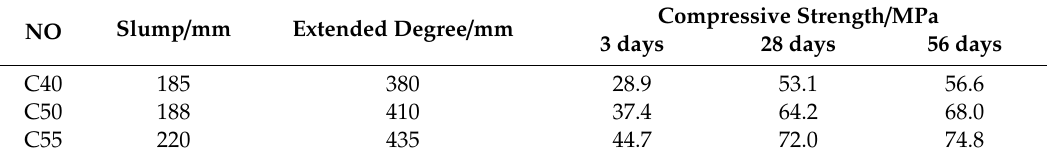
Table 3. The slump, extended degree, and compressive strength of architectural concrete.